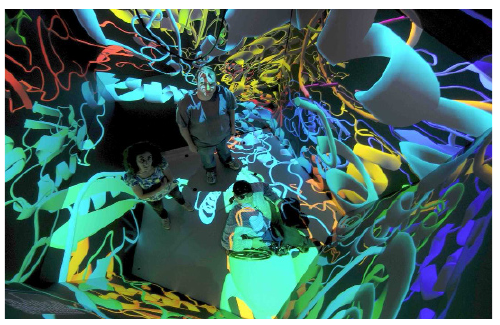
Figure 3. Calit2’s StarCAVE from above. Photo: Tom DeFanti.